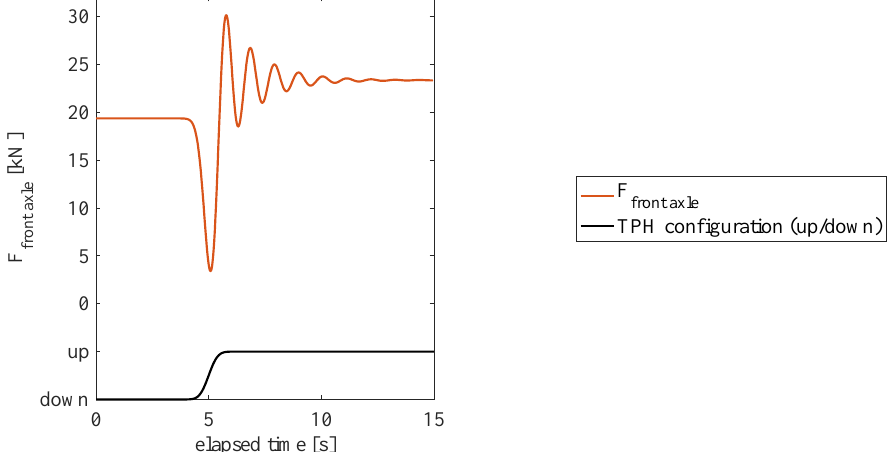
Figure 12. Simulated front axle response due to the reference manoeuvre performed with the reference implement on the reference soil.